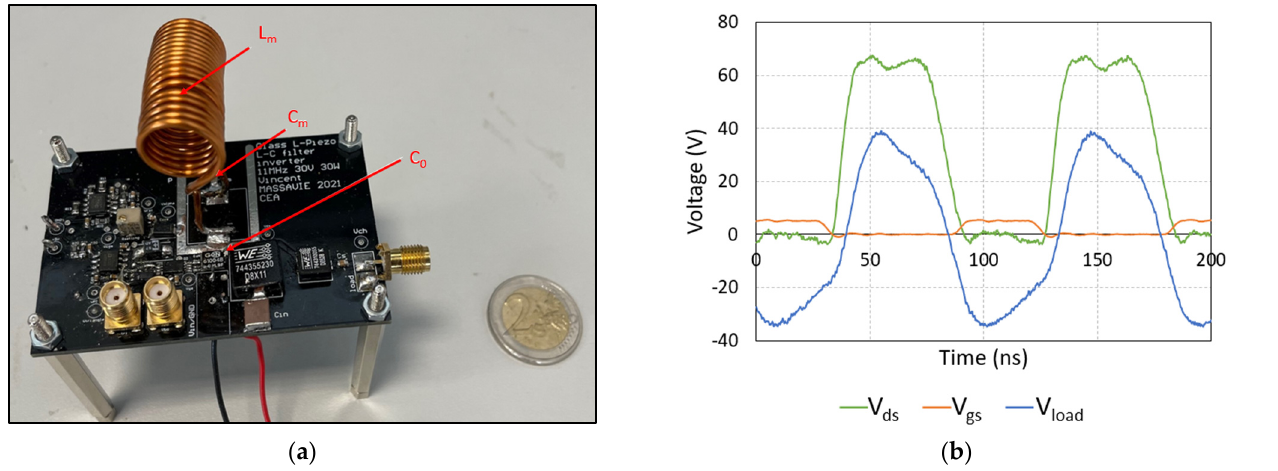
Figure 10. Prototype with passive LC filter ( a ) and characteristic voltages of the inverter ( b ).